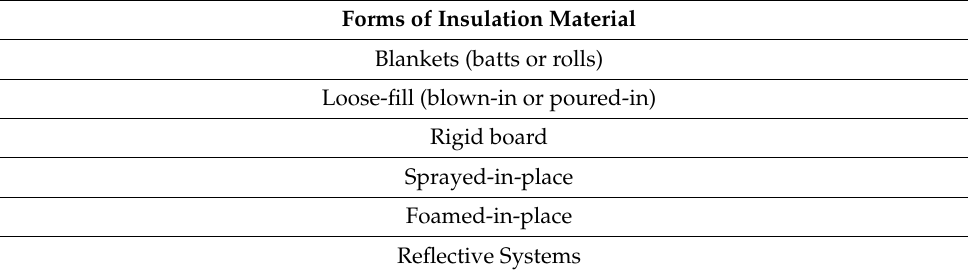
Table 2. Conventional forms of insulation material (adopted from